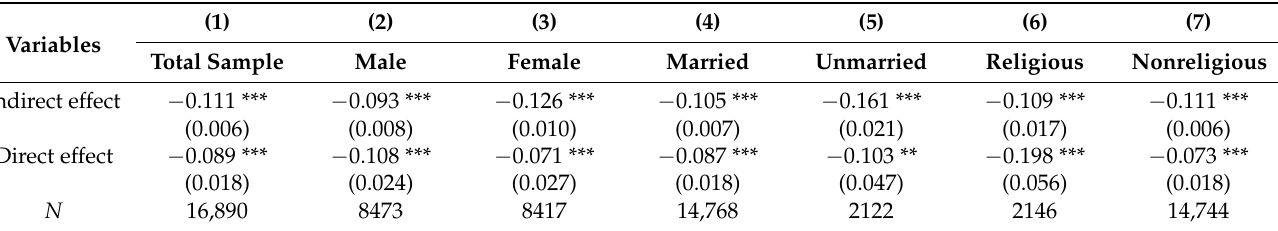
Table 9. Mediating effect of life satisfaction in impacts of work value perception on workers’ mental health.